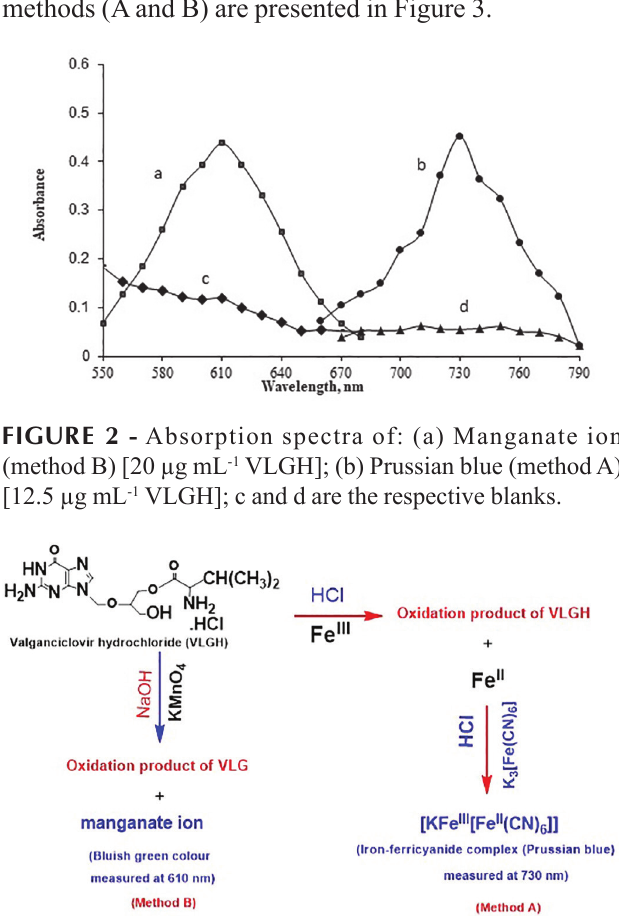
FIGURE 3 - The possible reaction pathways.